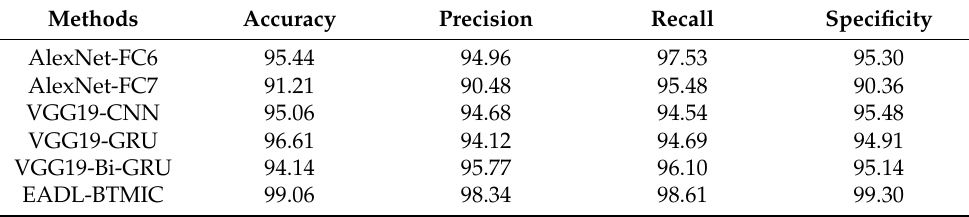
Table 4. Comparative analysis of EADL-BTMIC approach with recent algorithms. Methods